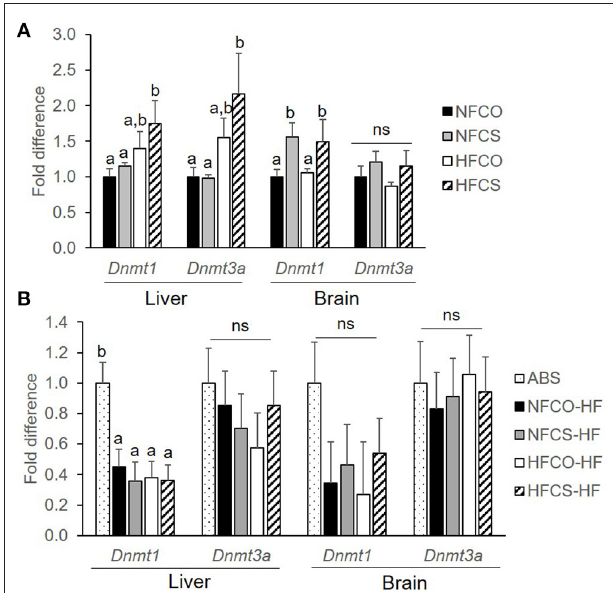
FIGURE 5 | Dnmt mRNA expression of mouse offspring was upregulated by maternal CS in the prenatal period. Dnmt mRNA expression of mouse offspring with different maternal diets at E17.5 (A) and after 6-week post-weaning high-fat feeding (B) . Different letters (e.g., a, b) represent statistically significant difference, p < 0.05; ns, represents no significant difference. n = 6–8 per sex per group. ABS, absolute control; CO, control without choline supplement; CS, choline supplemented; HF, high-fat; NF, normal-fat. Dnmt , DNA